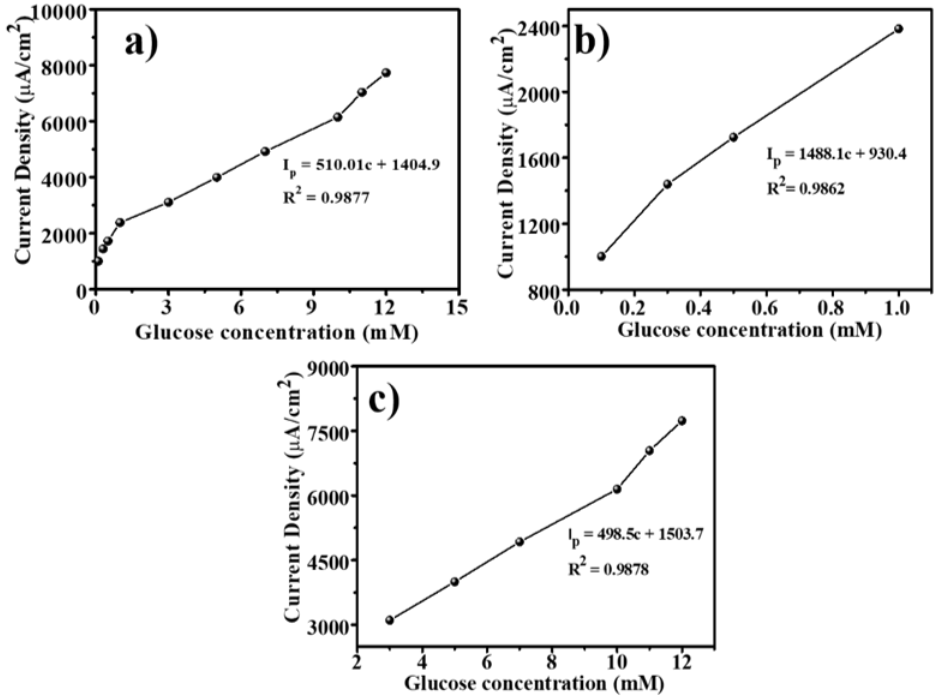
Figure 6. Calibration curve for glucose concentration determination using the Glucose liquid color kit ( a ) 0.1–12 mM ( b ) 0.1–1 mM ( c ) 3–12 mM for different glucose concentration.